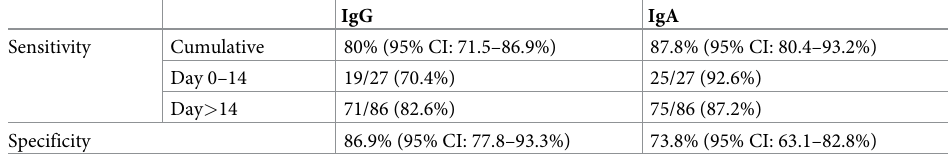
Table 4. Performance characteristics of EUROIMMUN Anti-SARS-CoV-2 IgA and IgG assays against in-house serology.